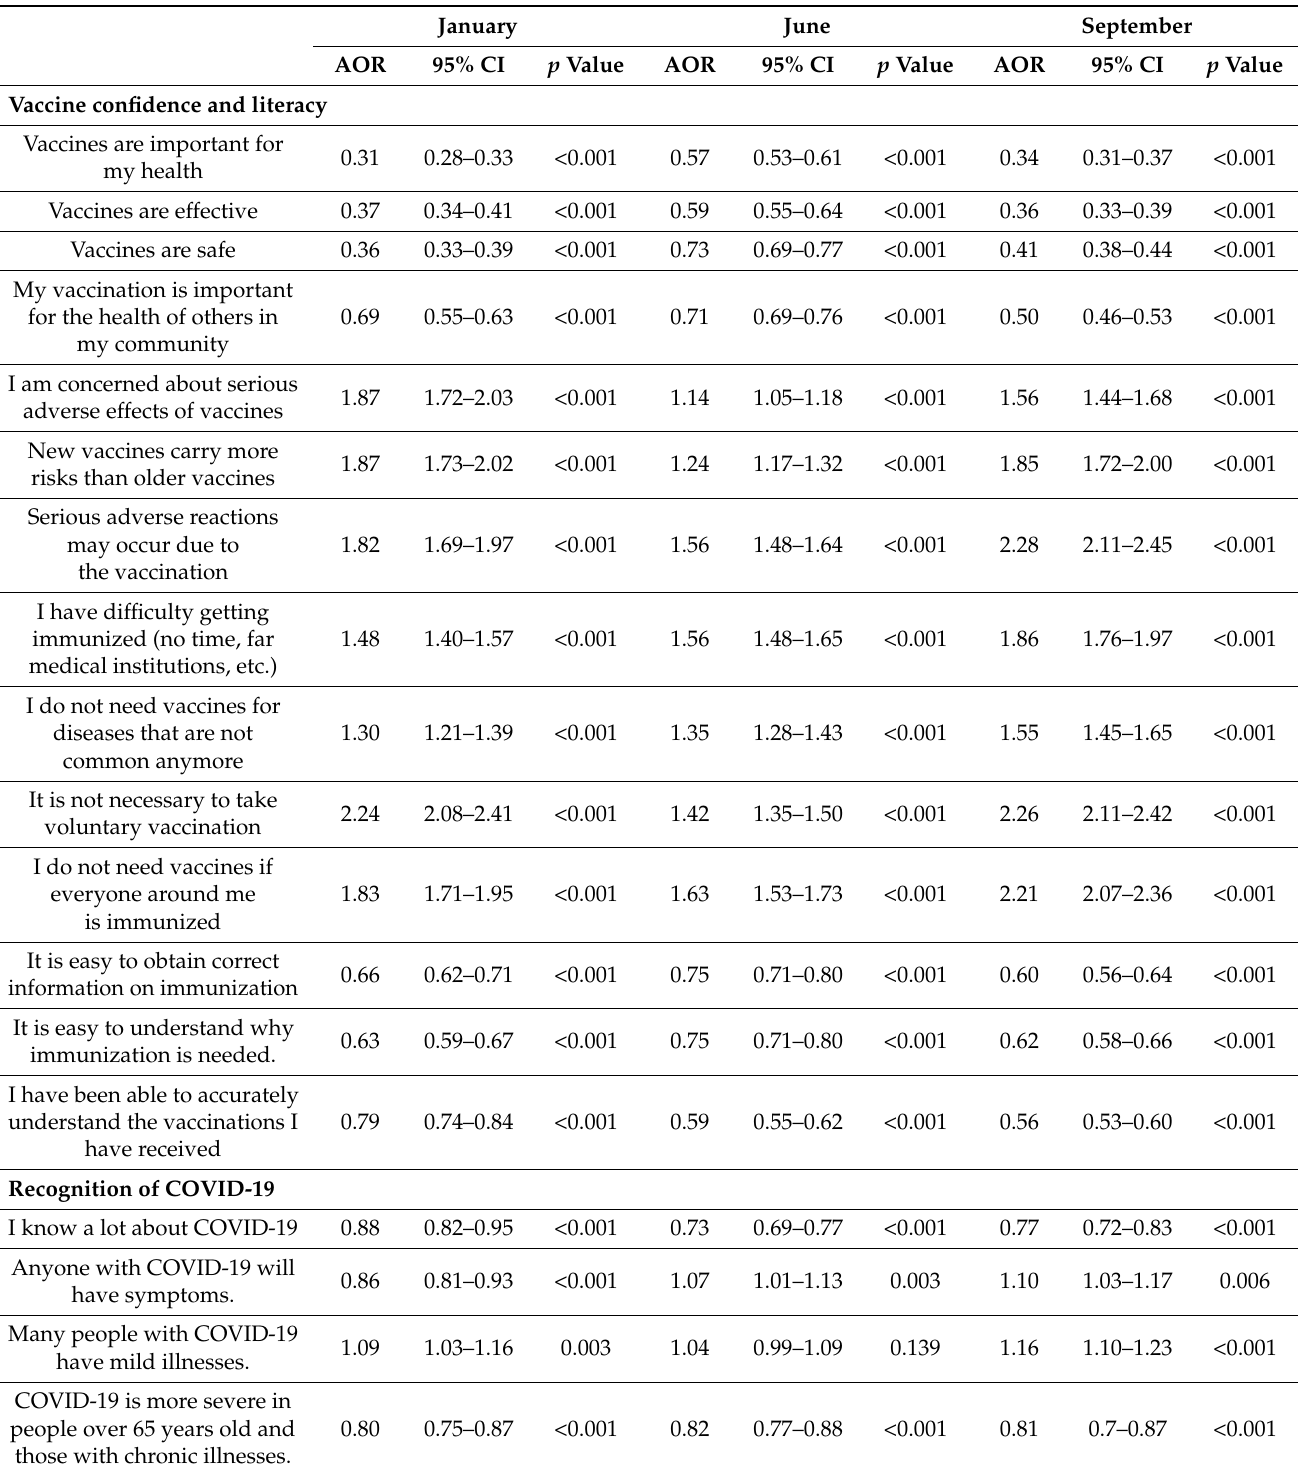
Table 3. Age and sex adjusted odds ratio (OR) of vaccine hesitancy according to vaccine confidence and literacy by